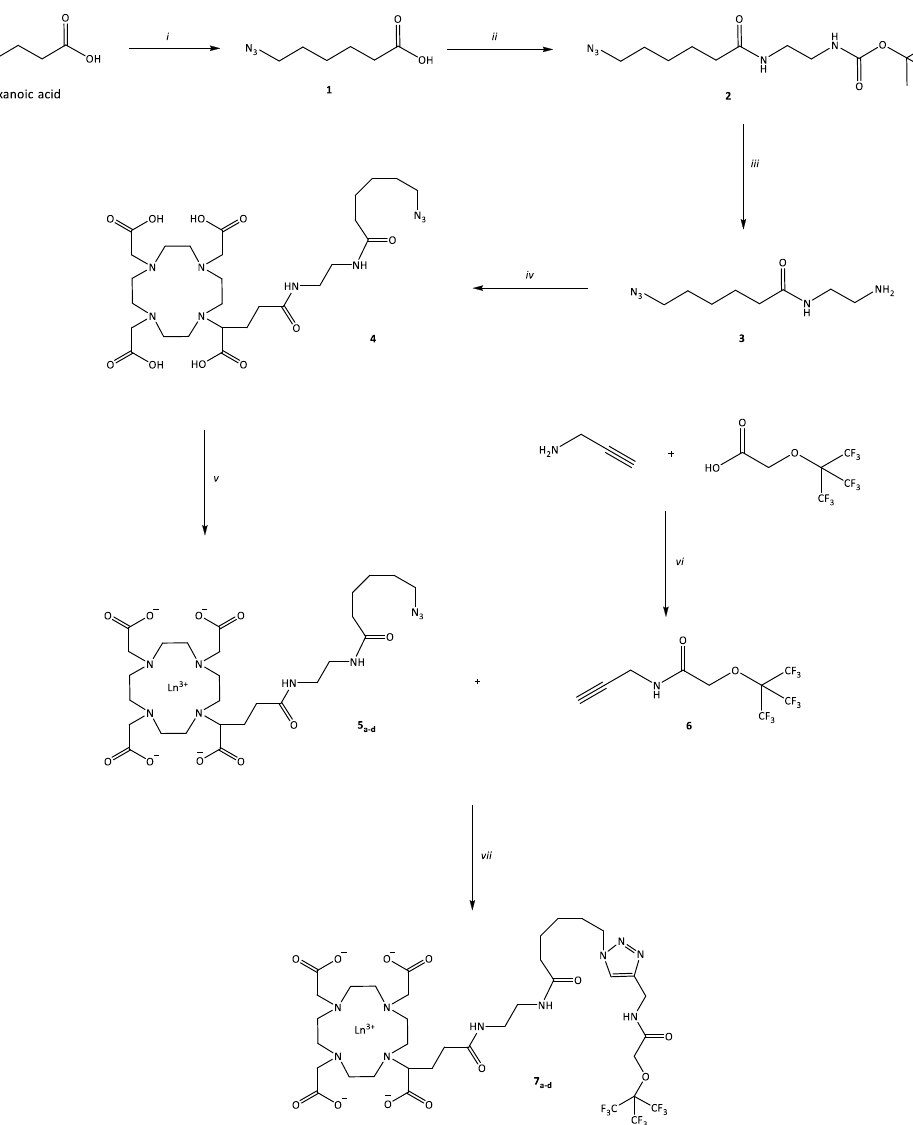
Scheme 1. Multi-step synthesis of the fluorinated lanthanide complexes reported in this